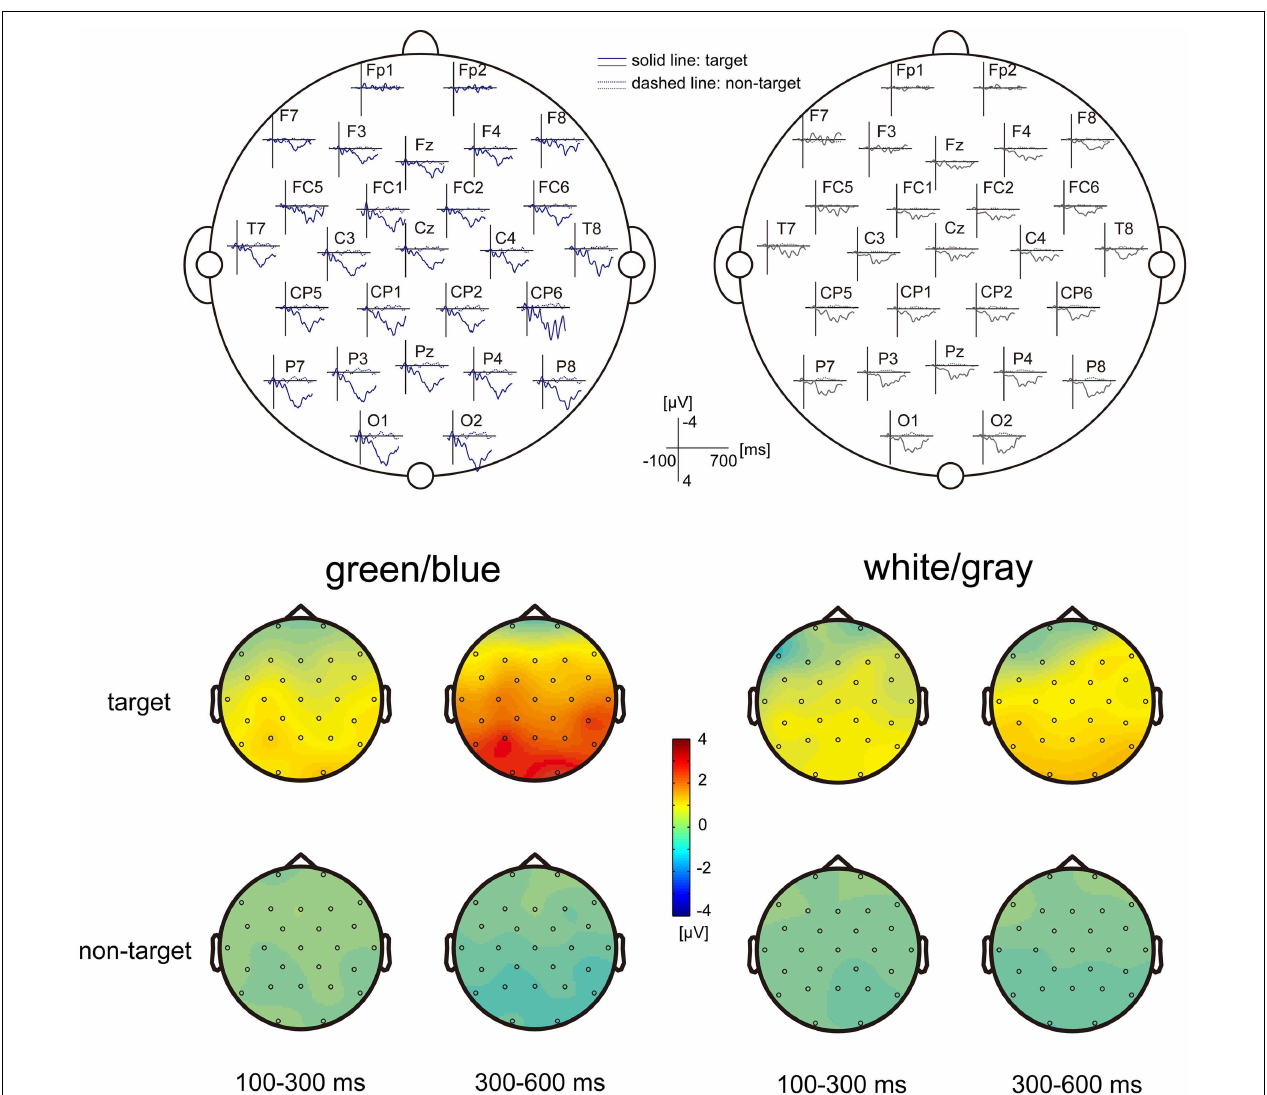
both conditions, particularly over the parietal and occipital areas. (Lower)The scalp distribution of the early component (100–300ms), and the late component (300–600ms).The difference between the target and non-target was prominent in the late component under the green/blue condition and was located at the parietal and occipital